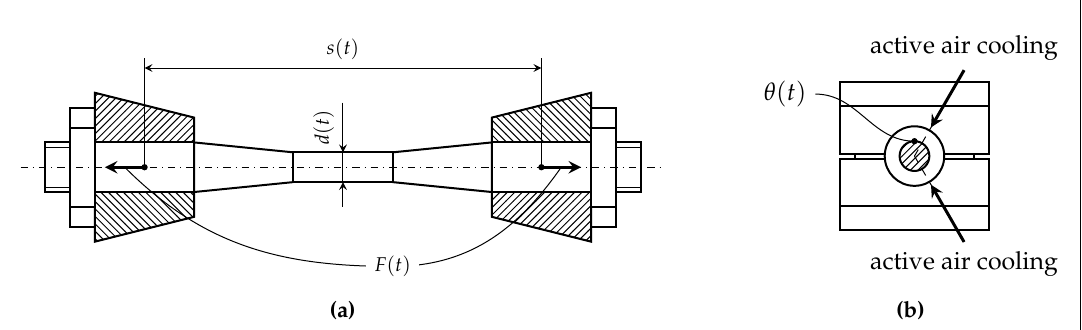
Figure 3. Gleeble 3500 machine setup ( a ) installed test specimen, ( b ) positions of the air cooling